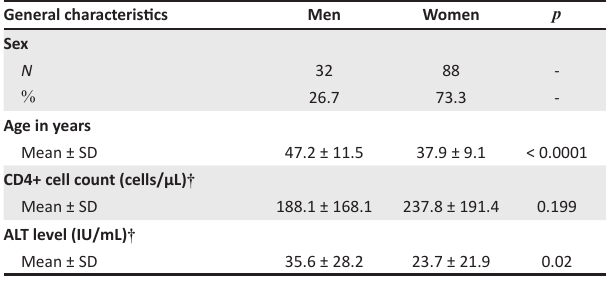
TABLE 1: Patient characteristics by sex, Jos University Teaching Hospital HIV clinic, August 2015. General characteristics